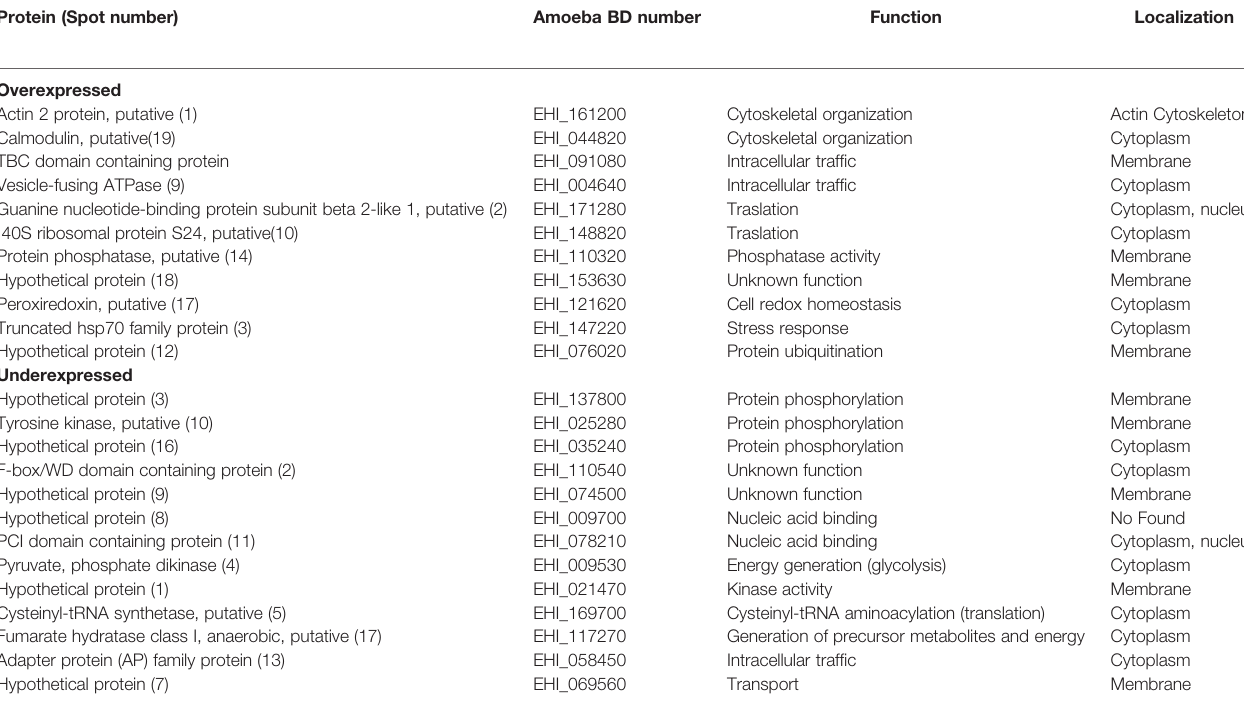
TABLE 3 | Functional categorization of E. histolytica proteins modulated by treatment with T-001. Protein (Spot number)